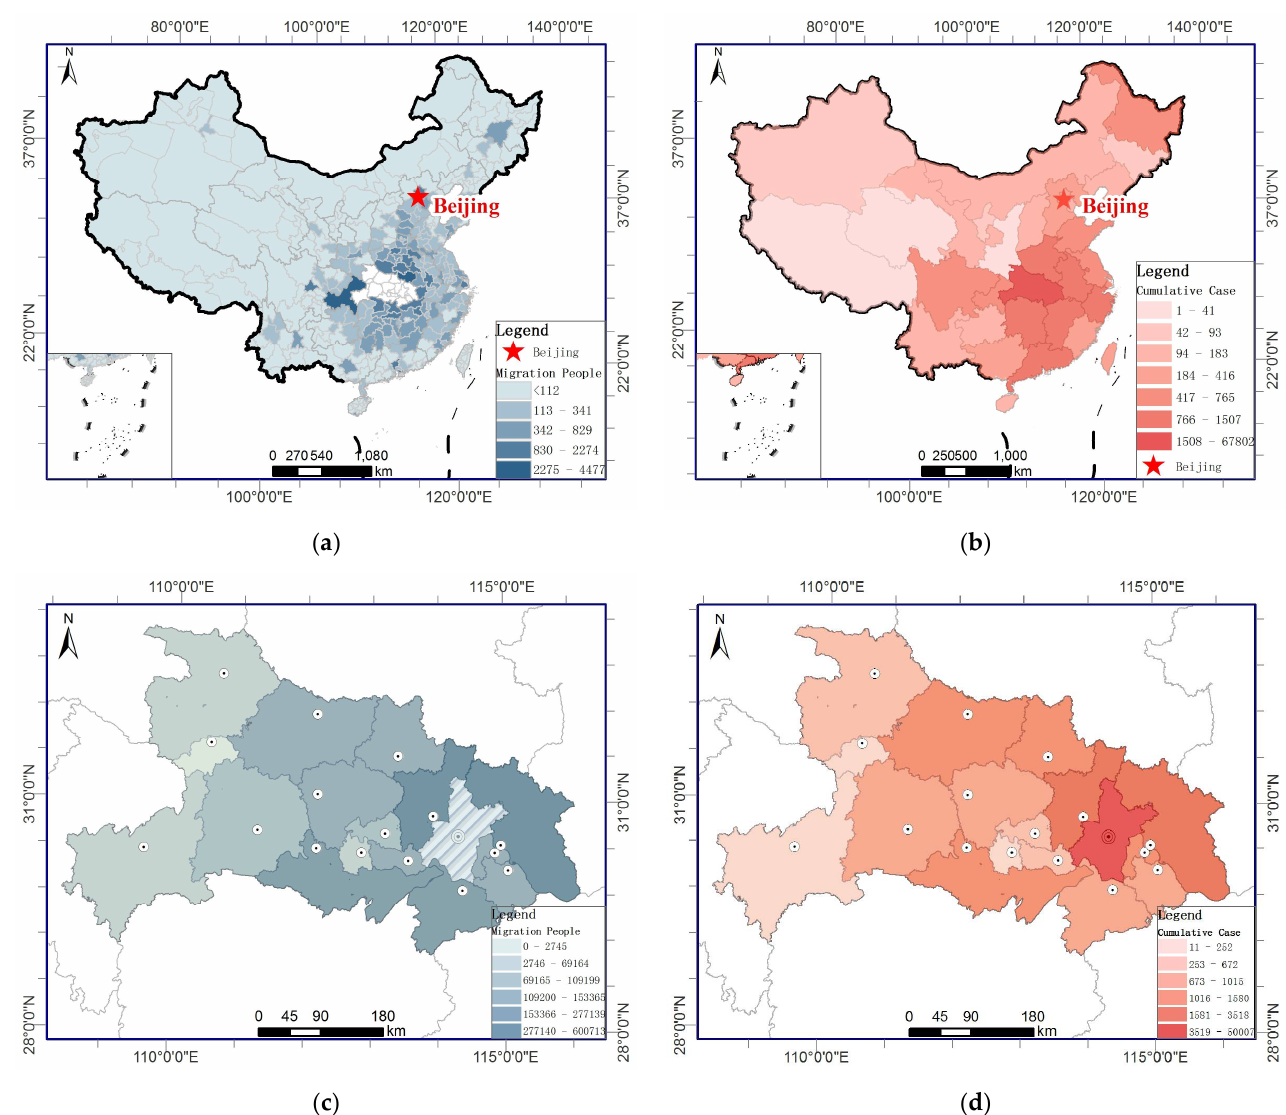
Figure 12. Distributions of outflows from Wuhan and the confirmed cases (( a ) outflows from Wuhan to other cities in China before the Spring Festival; ( b ) confirmed cases in China; ( c ) outflows from Wuhan to other cities in Hubei before the Spring Festival; ( d ) confirmed cases in Hubei province).